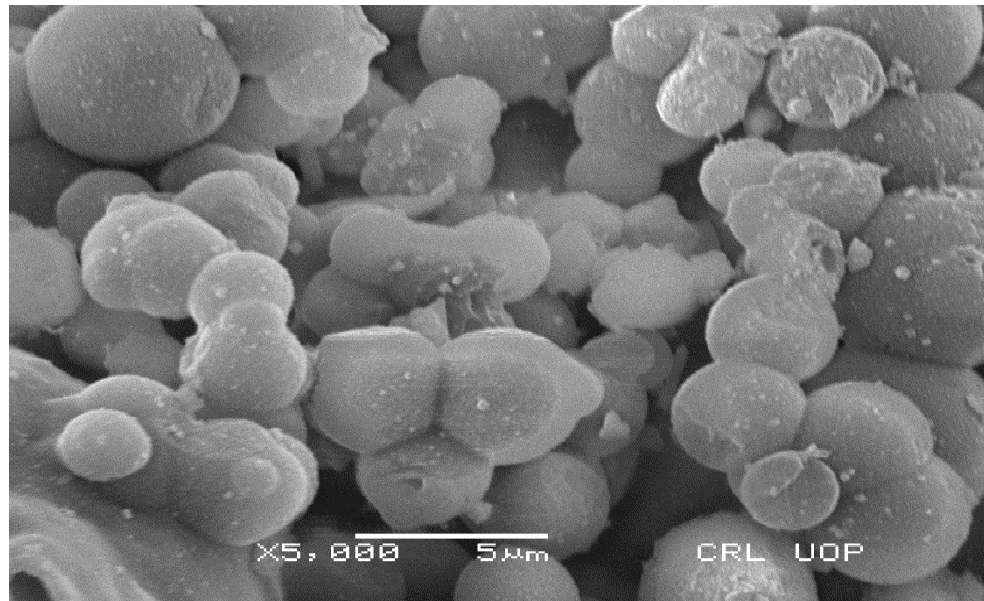
Figure 3. XRD pattern of T. couneifolia AgNPs.